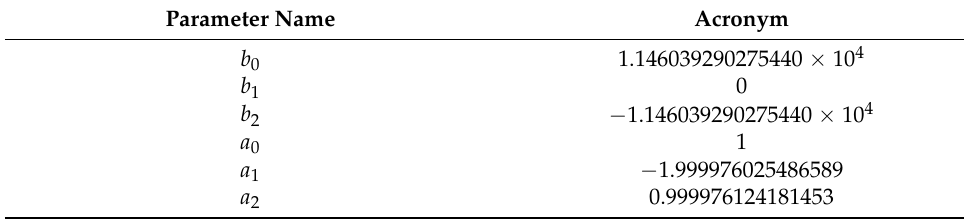
Table 3. Power and current loops’ PR resonant filter parameters.